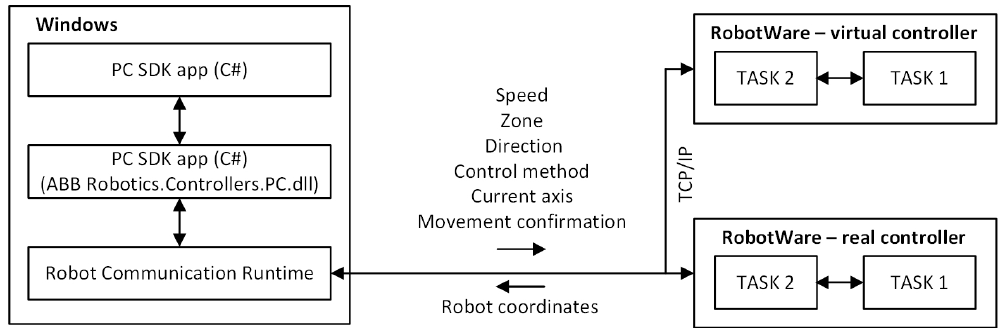
Figure 5. General diagram of communication between the application and the robot